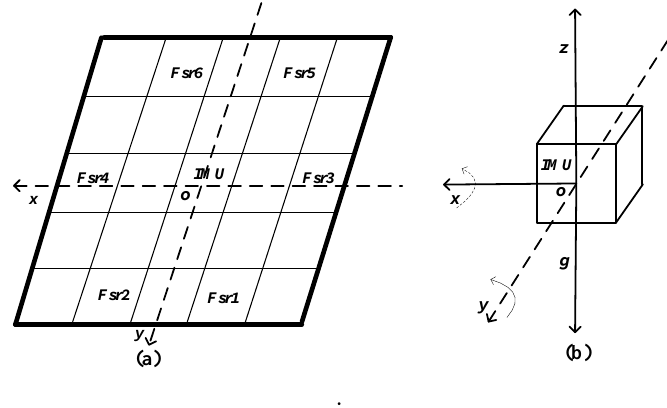
Figure 2. Sensors deployment of the smart cushion: ( a ) schematic diagram of the sensors deployment on the base board; ( b ) IMU sensor and the three axis